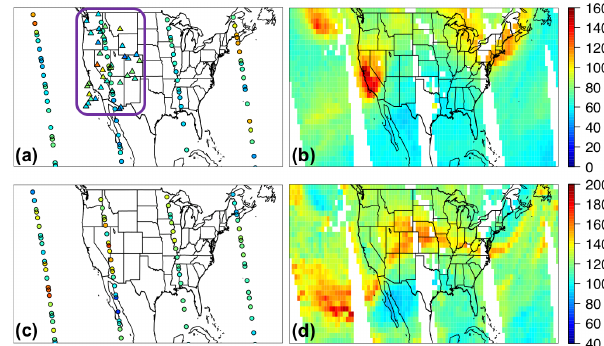
Figure 13. Case study of 9 May 2010: (a–b) Ozone (ppbv) and (c–d) CO (ppbv) at ∼ 500hPa from the L2 (a, c) TES retrievals (circles) and (b, d) L3 AIRS products at early afternoon local time. The L2 IASI O 3 (ppbv) at ∼ 500hPa retrieved using the TES al- gorithm (details in Sect. 2.3.2) at the mid-morning local times is shown on (b) as triangles. The O 3 profiles within the purple box in (a) were used in the model evaluation shown in Fig. 14.